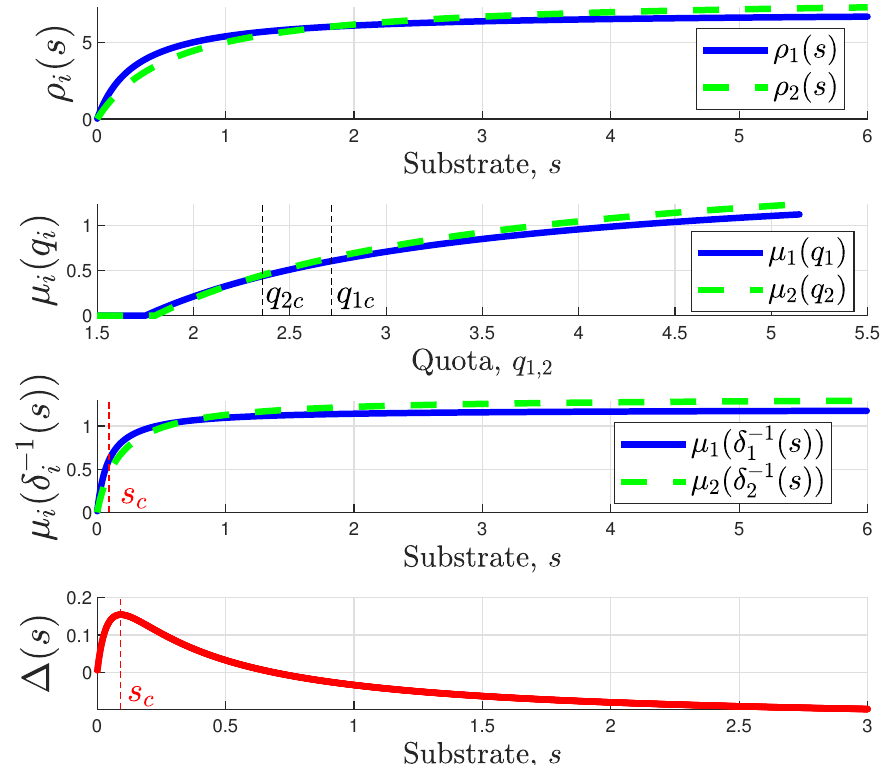
Figure 7. Growth and absorption (uptake) functions, respectively µ i and ρ i , i = 1,2, produced using the model parameters given in Table 1, and used throughout the Examples 1–3. We note that the value of s that maximizes the function ∆ ( s ) is given s c = 0.092. This point maximizes the difference between the actual growth rates (as discussed in Section 2.3) and defines the unique static solution ( s c , q ) . All the assumptions that ensure the well-posedness of the generic (6) are satisfied in this 1 c , q 2 c case. In particular, we highlight that ∆ ( s ) can be positive and negative, and both species may win the competition using an appropriate control D (see Section